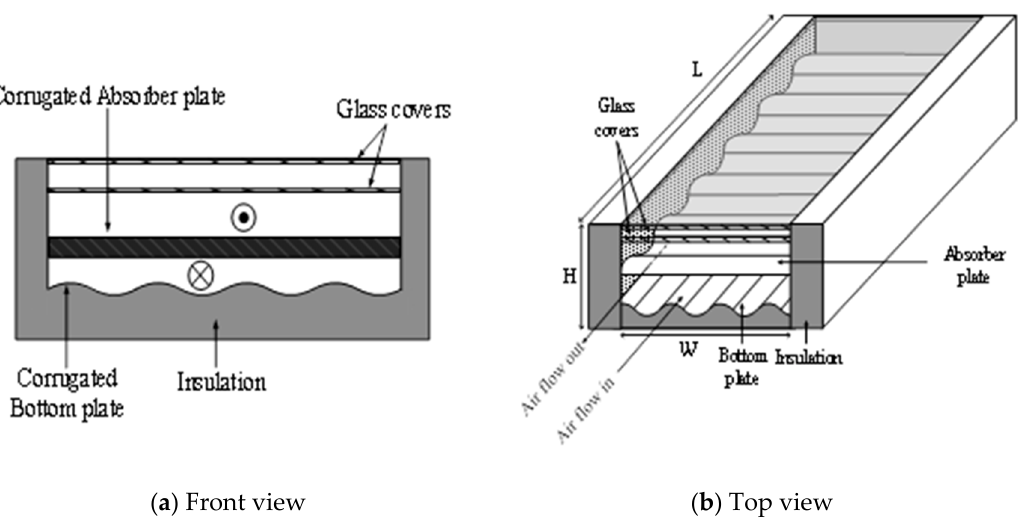
Figure 1. A schematic drawing of a recycling double-pass cross-corrugated solar air heater. Type A: Internal recycling at the upper channel